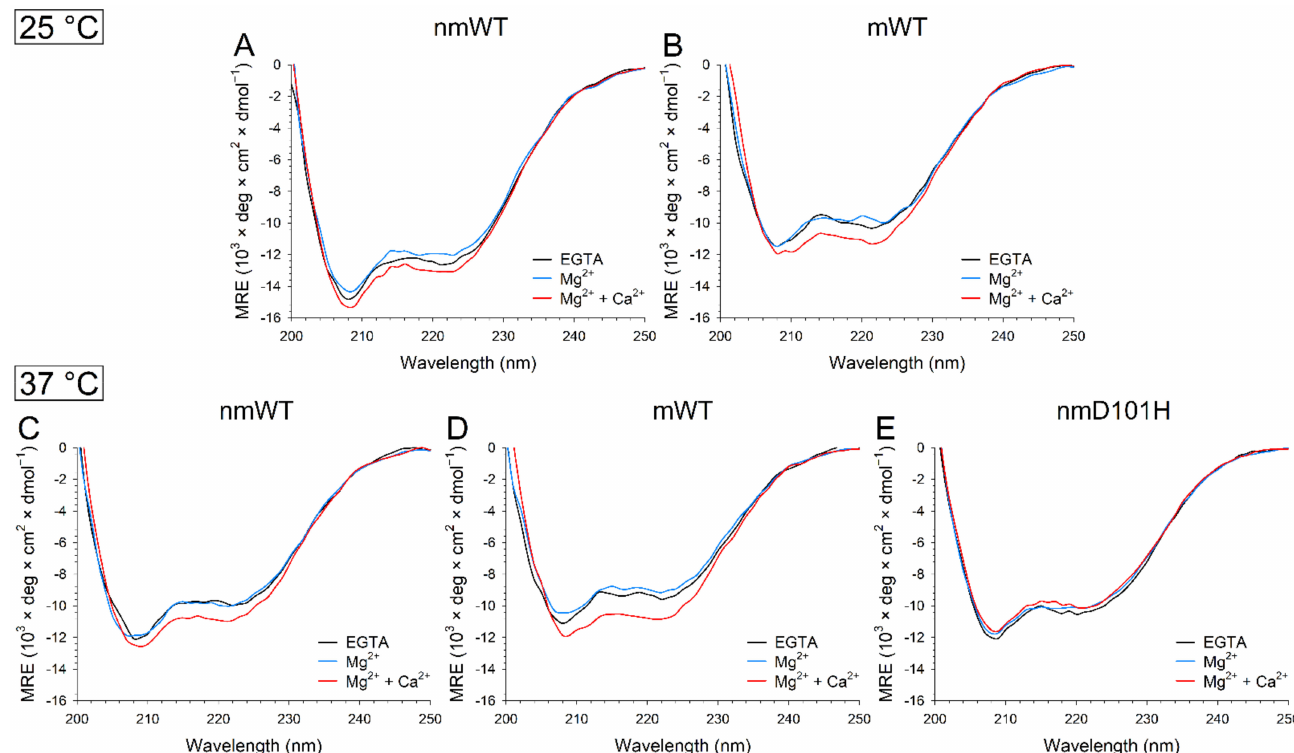
Figure 6. Representative far UV CD spectra recorded at 25 ◦ C of ~8 µ M ( A ) nmWT; and ( B ) mWT GCAP3 in the presence of 300 µ M EGTA (black) and after sequential additions of 1 mM Mg 2+ (blue) and 600 µ M Ca 2+ (red), leading to approximately 300 µ M free Ca 2+ . Representative far UV CD spectra recorded at 37 ◦ C of ~8 µ M ( C ) nmWT; ( D ) mWT; and ( E ) nmD101H GCAP3 in the same experimental conditions as